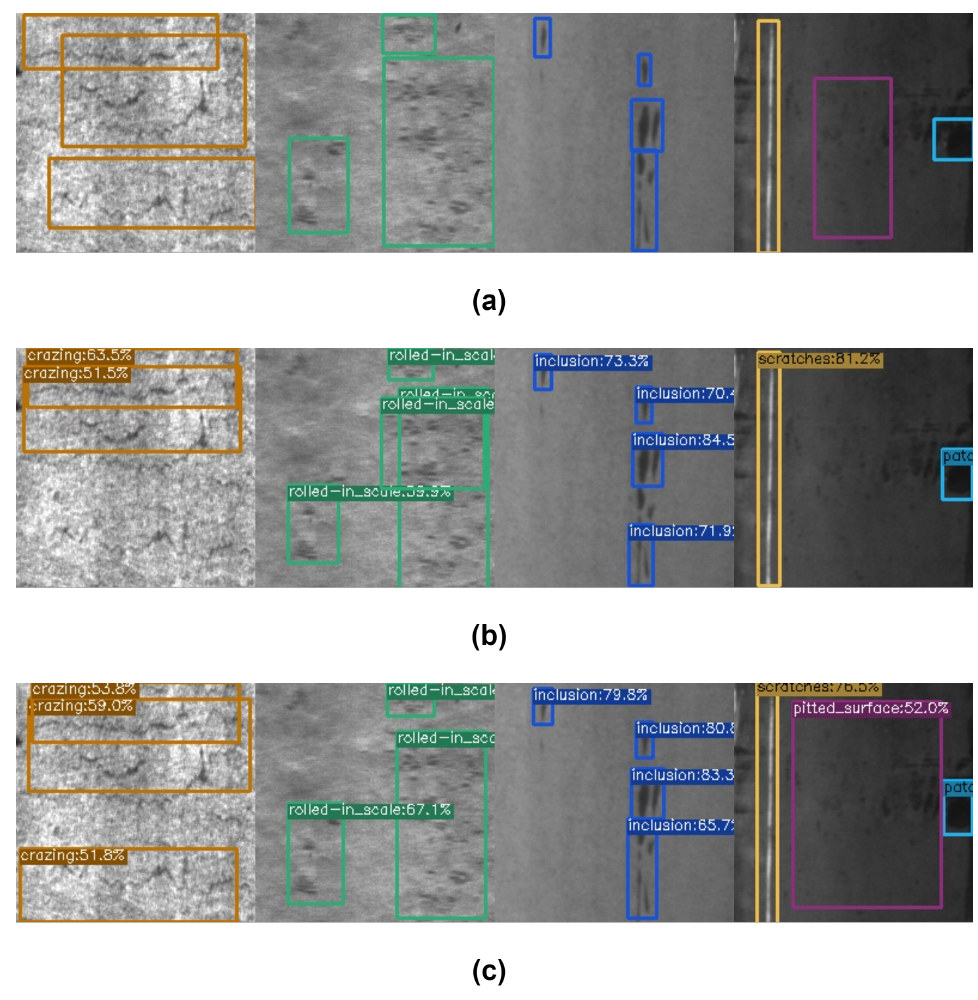
Figure 8. The NEU-DET dataset results. ( a ) Ground truth of the dataset. ( b ) Baseline prediction label. ( c ) Model prediction label of this